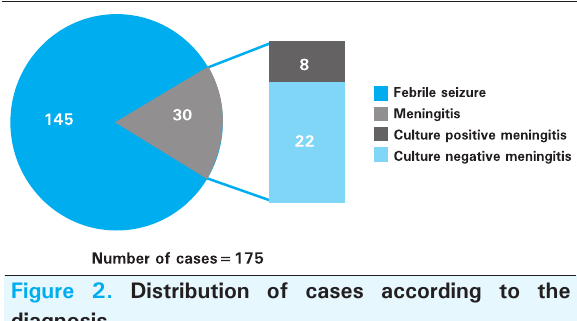
Figure 2. Distribution of cases according to the diagnosis Children of less than 12 months were found to have meningitis significantly ( p = 0.001) as compared to older children. In the age group of 6 – 12 months, 17 cases (32%) had meningitis while in 12-18 months, 9 out of 43 cases (20%) had meningitis and in more than 18 months age group 4 out of 79 cases (5%) were detected with meningitis (Table